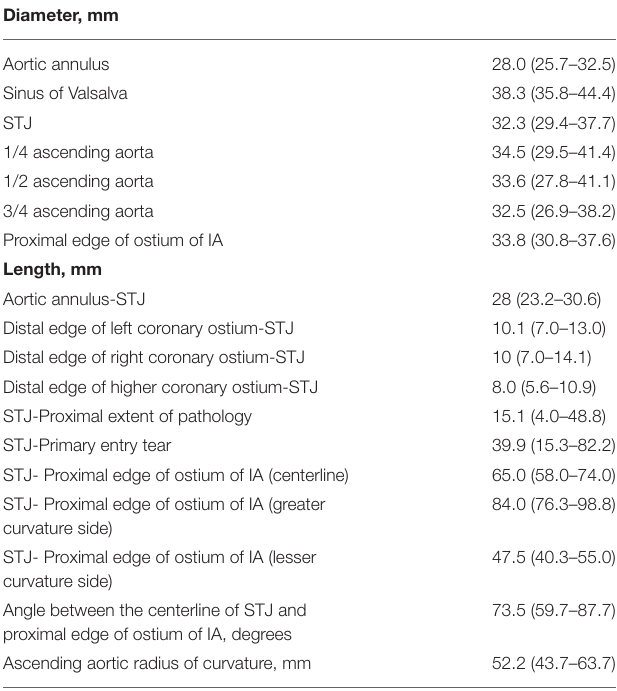
TABLE 1 | Anatomical measurements [median (interquartile range), n =